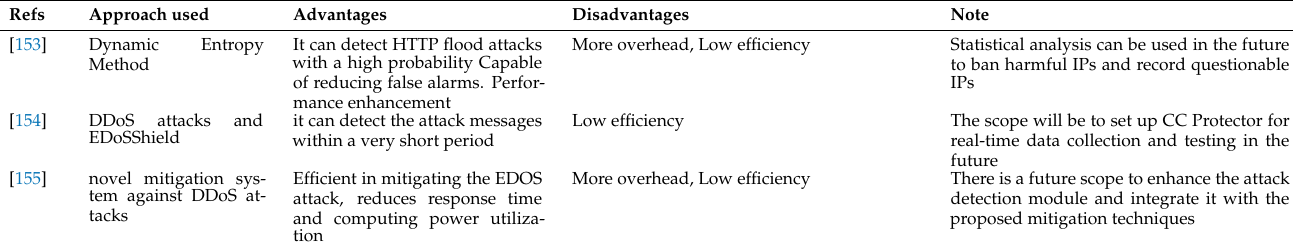
Table 17. Advantages and disadvantages of filtering tree-based detection